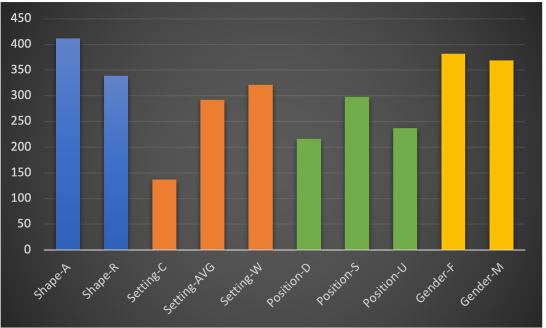
Figure 4. Distribution of attributes over 751 image (per one camera).